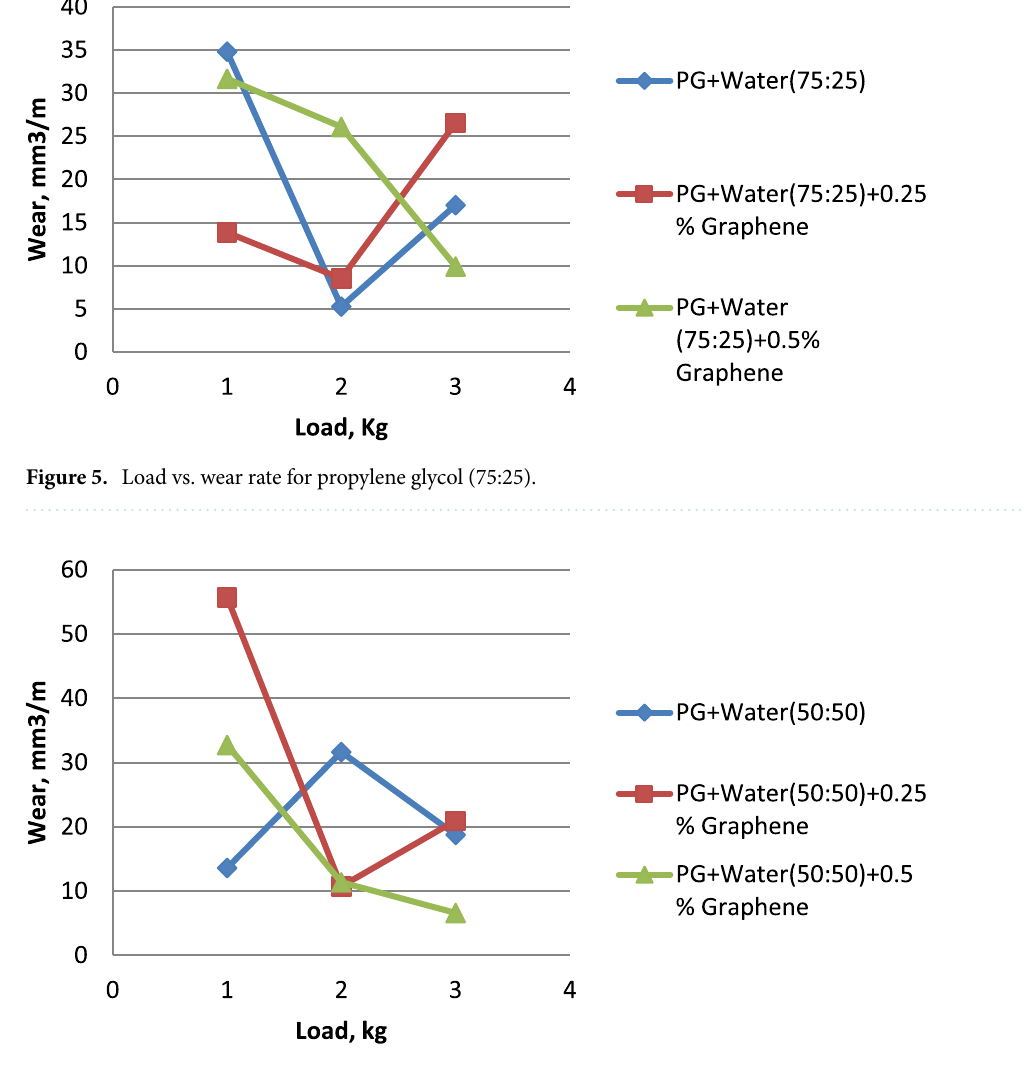
Figure 6. Load vs. wear rate for propylene glycol